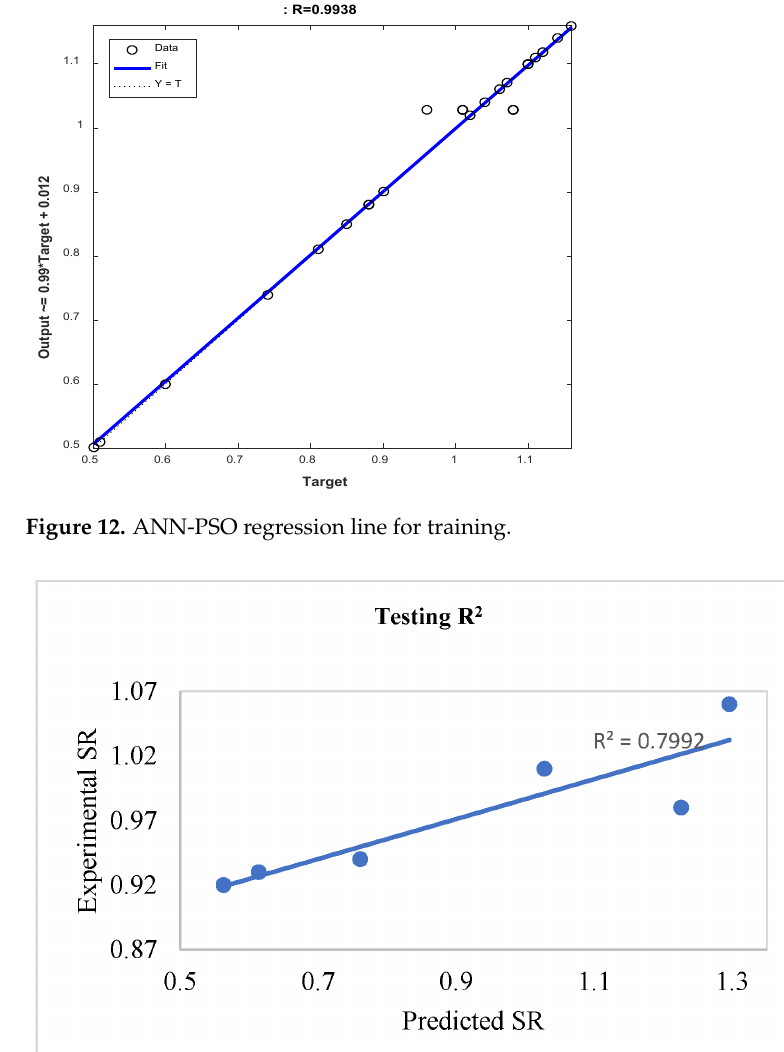
Table 6. ANN-GA training results.